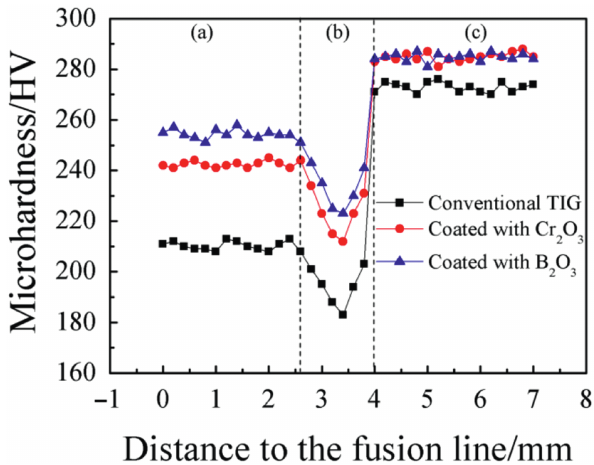
Figure 7: Microhardness distribution of the heat-affected zone: (a) overheated zone; (b) incomplete recrystallization zone; and (c) substrate.